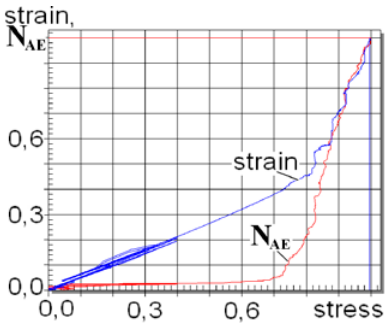
Fig. 6. Dependence of the cumulative AE and the deformation on the stress-strain of a sample with transverse fibers with a triple training corresponding to 40% of the breaking load (sample width: 20 mm)